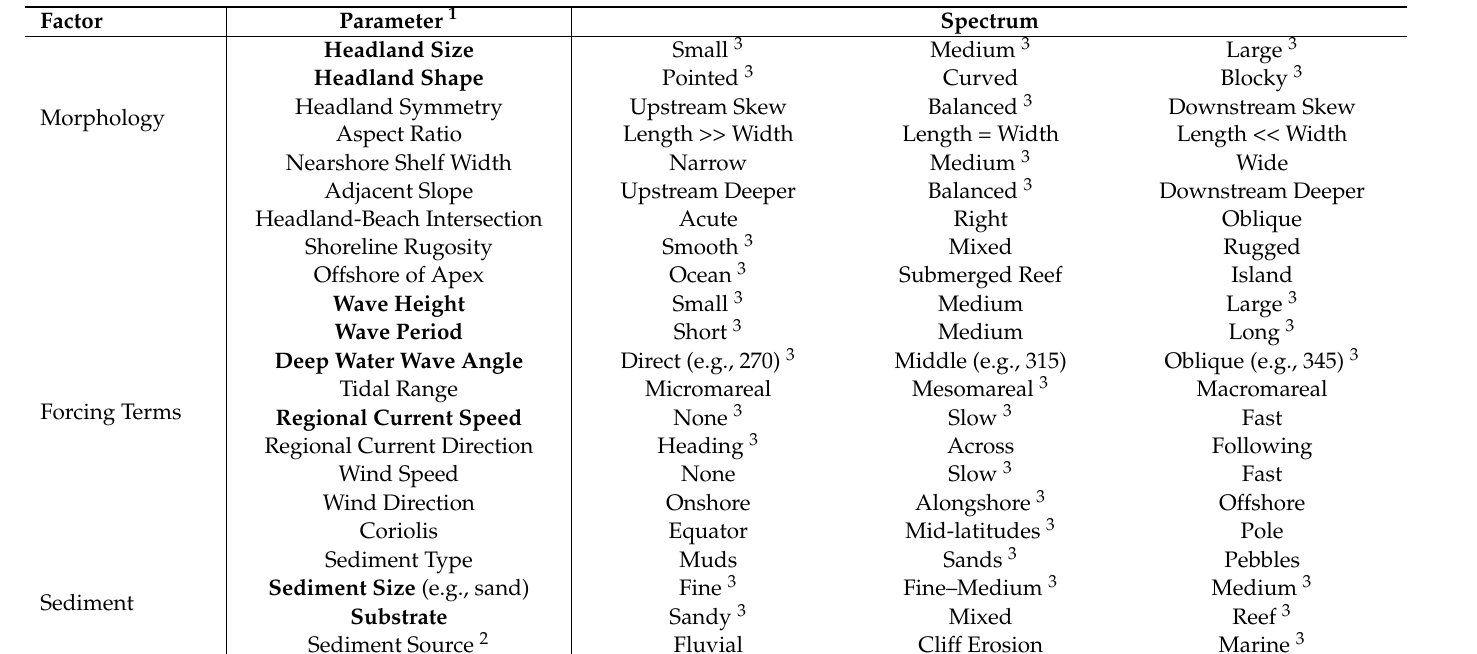
Table 1. Factors influencing sediment bypassing a